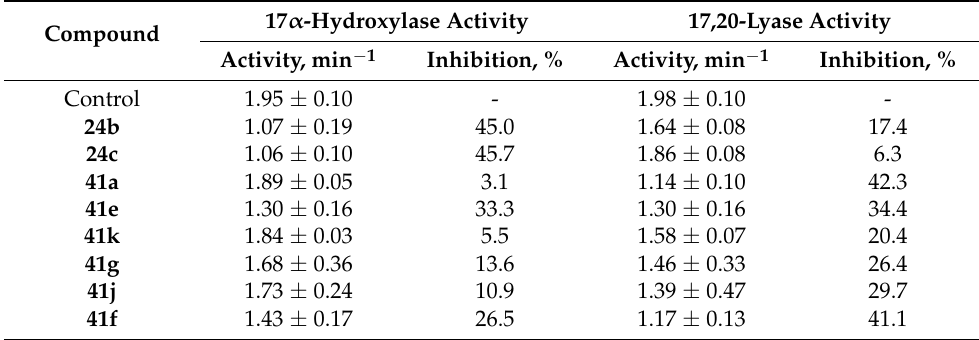
Table 2. Inhibitory effect of compounds on human CYP17A1-catalyzed reaction. 17 α -Hydroxylase Compound